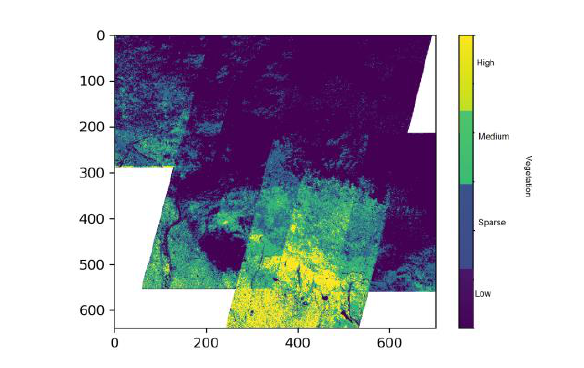
Figure 10. Reclassified NDVI of 2010